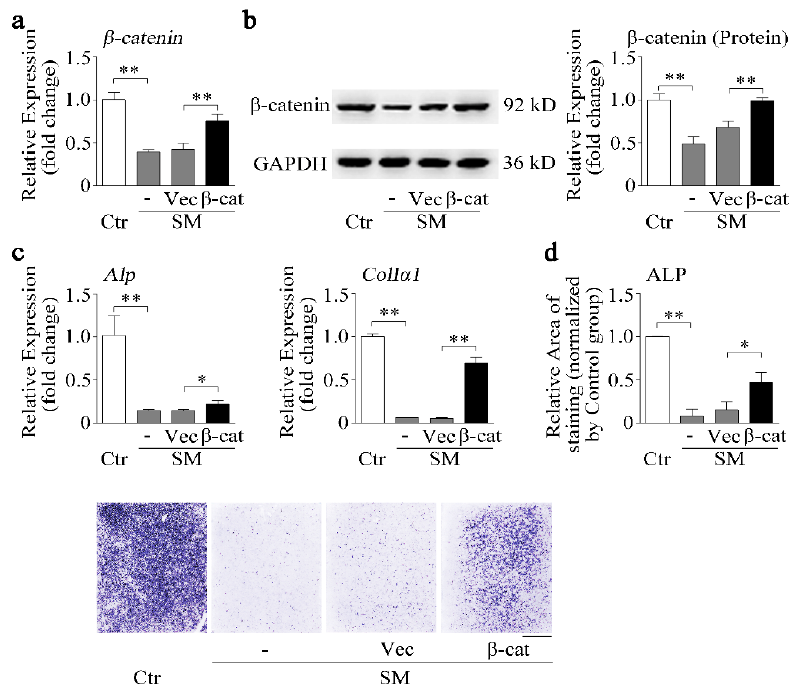
Figure 6. β -catenin overexpression recovers osteoblast di ff erentiation reduction induced by simulated microgravity. ( a ) Real-time PCR analysis of β -catenin in MC3T3-E1 cells after treatment with either the pcDNA3.1- β -catenin plasmid ( β -cat) or pcDNA3.1 blank vector (Vec) under RPM simulated microgravity for 48 h; n = 3. ( b ) Western blot analysis and quantification of β -catenin protein level in MC3T3-E1 cells after treatment with either the β -cat plasmid or blank vector under RPM simulated microgravity for 48 h; n = 3. ( c ) Real-time PCR analysis of Alp and ColI α 1 in MC3T3-E1 cells after treatment with the β -cat plasmid or blank vector under RPM simulated microgravity for 48 h; n = 3. ( d ) Representative images of ALP staining and quantification of staining areas in MC3T3-E1 cells after treatment with the β -cat plasmid or blank vector under RPM simulated microgravity for 48 h. Scale bar, 5 mm. Gapdh was used as the internal control for mRNA. Ctr: control; SM: simulated microgravity; β -cat: pcDNA3.1- β -catenin plasmid; Vec: pcDNA3.1 blank vector. All data are the mean ± SD. Statistical di ff erences between the two groups were determined by the Student’s t- test; * p < 0.05, ** p < 0.01.